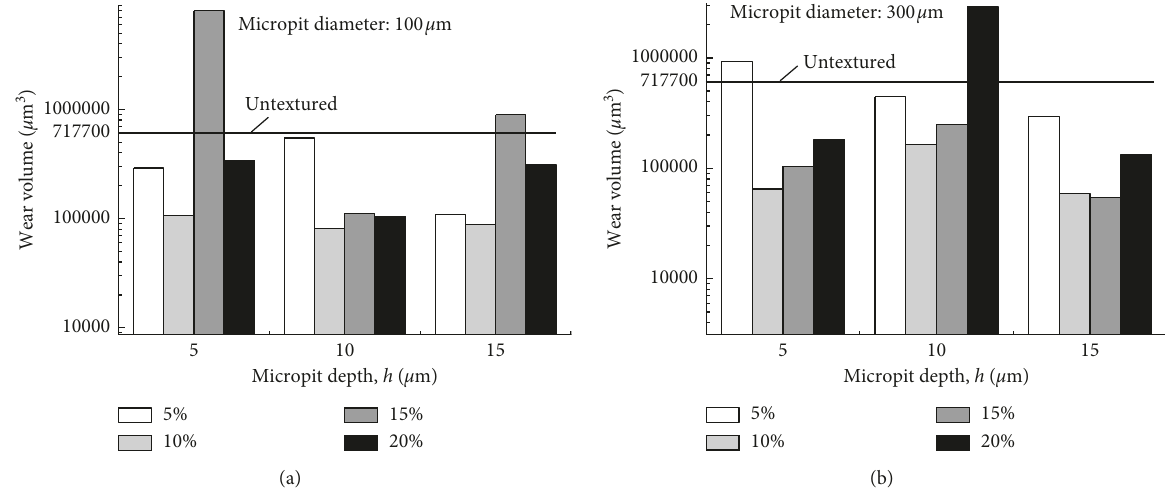
Figure 7: Relation of micropits’ depth and wear volume. The micropit diameters of (a) 100 μ m and (b) 300 μ m.